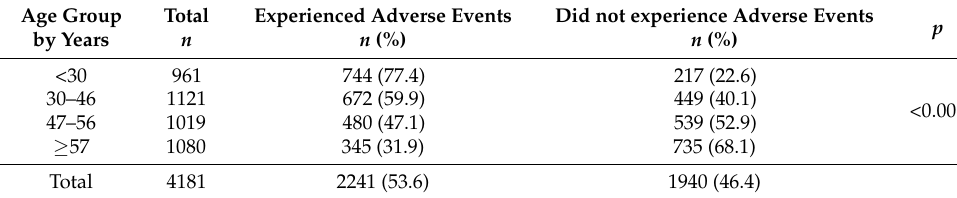
Table 2. Incidence of adverse events by different age groups.